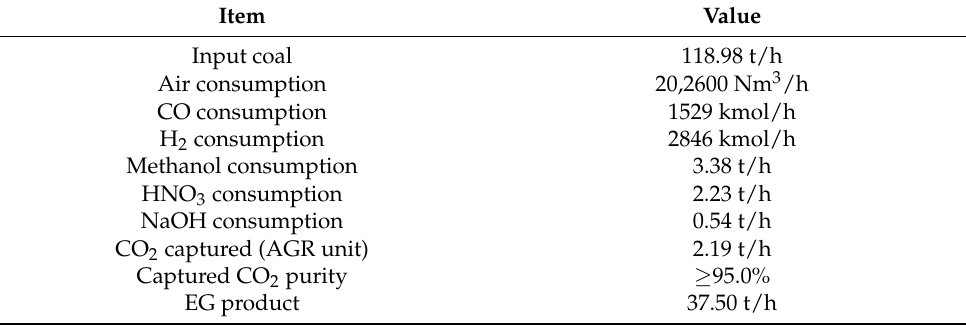
Table 4. Basic performance of the CTEG